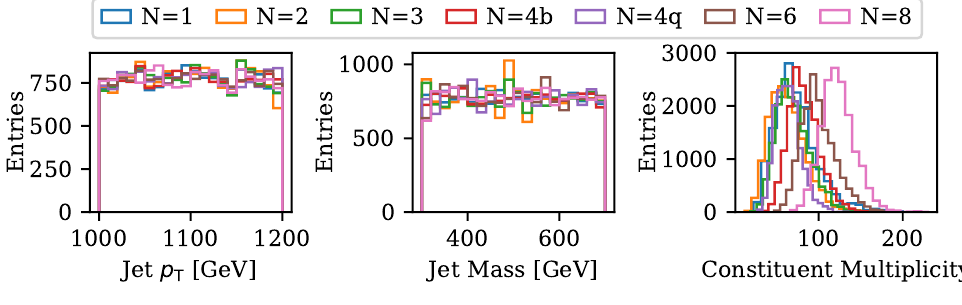
Figure 2 . Distributions of jet p T , mass, and constituent multiplicity for the simulated jets with N = 1 , 2 , 3 , 4 b, 4 q, 6 , 8 hard